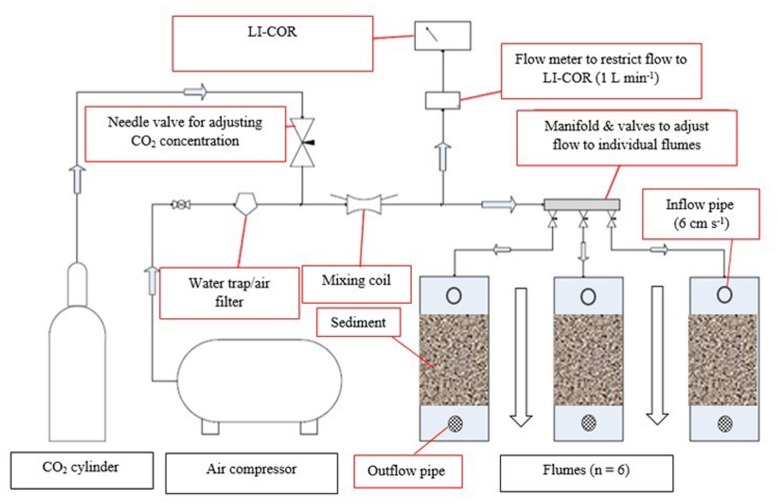
Experimental set up of the elevated CO2 system (750 ppm CO2). Dried ambient air from an external compressor is mixed with pure CO2 in a mixing coil and flowing (1 L min-1) into individual flumes and through a LI-COR 820 for continuous monitoring of concentration. The same set up was used for the ambient CO2 treatment (∼380 ppm CO2) for another three flumes, but without the addition of pure CO2. A recirculating flow of seawater via the inflow- and outflow-pipe was restricted to 6 cm s-1 and provided a unidirectional flow (indicated by a black-outlined arrow).